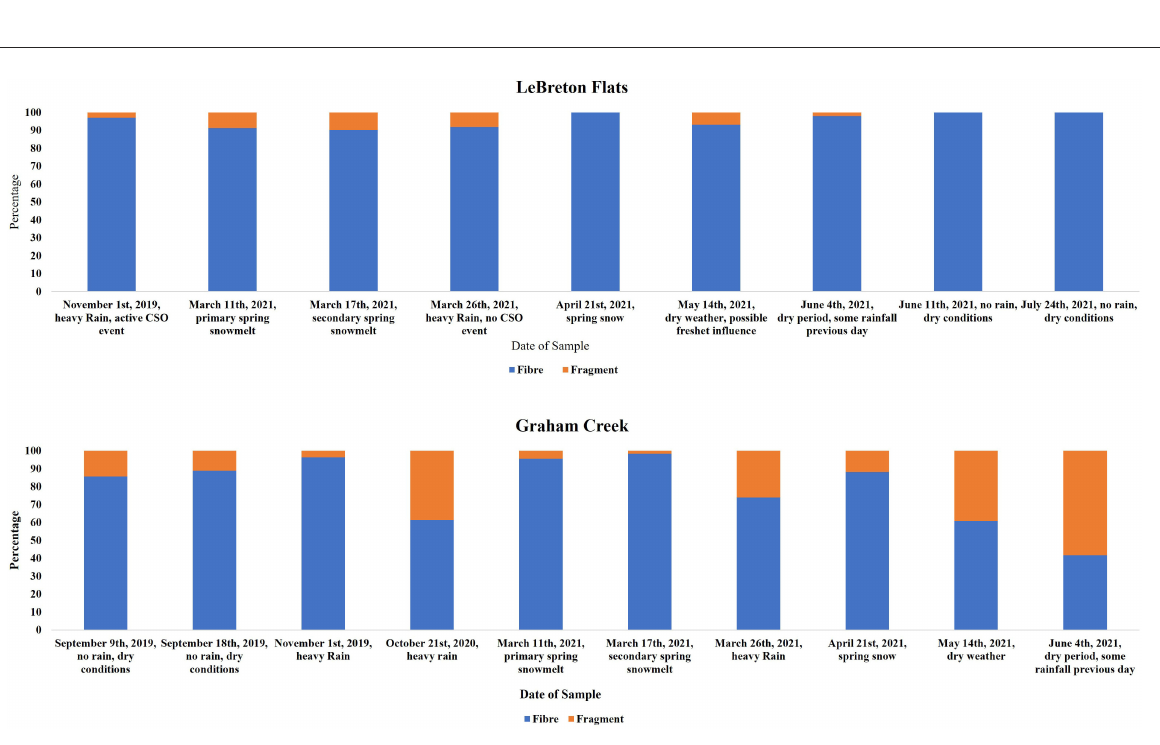
FIGURE3 Comparison between fibers and fragments during each sampled temporal event at Le Breton Flats and Graham